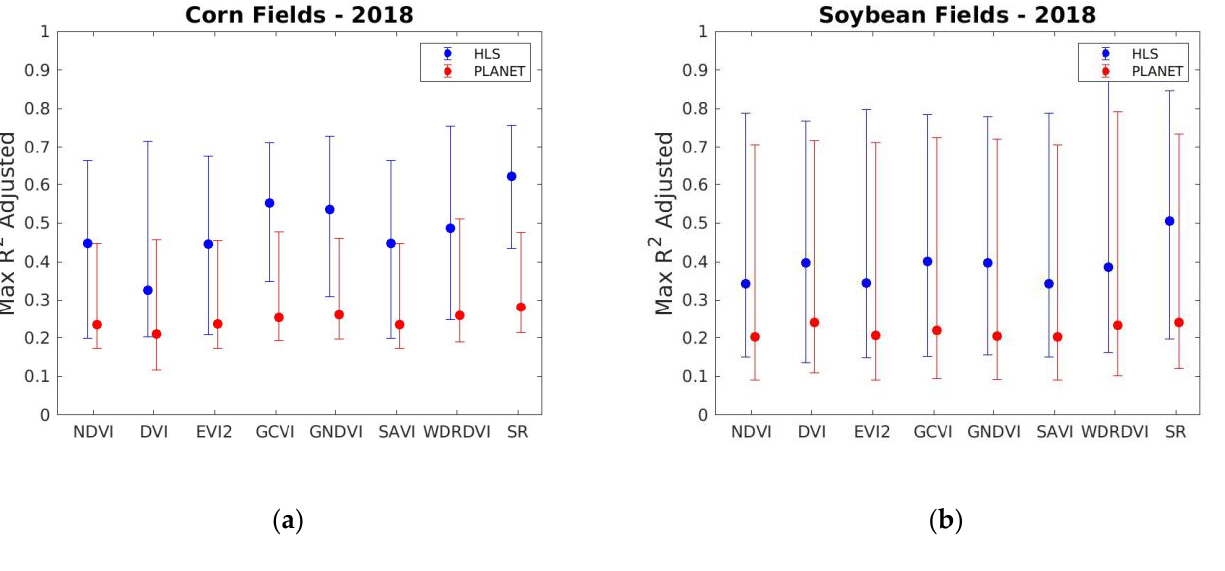
2 as a function of the day of year for the best and the worst fields using HLS- Figure 9. Coefficient of determination 𝑅 adj and Planet-derived SR values to correlate with yields: ( a ) corn in 2018; ( b ) soybean in 2018; ( c ) corn in 2019; ( d ) soybean in 2019.